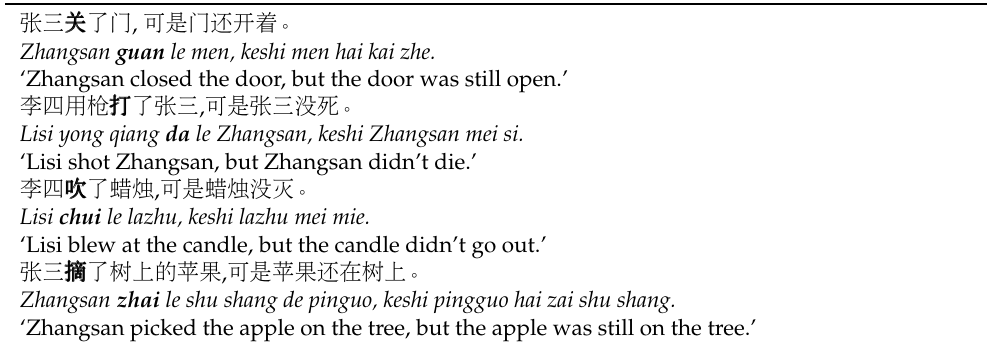
Table 2. Sample target sentences in the rating task (target verbs in